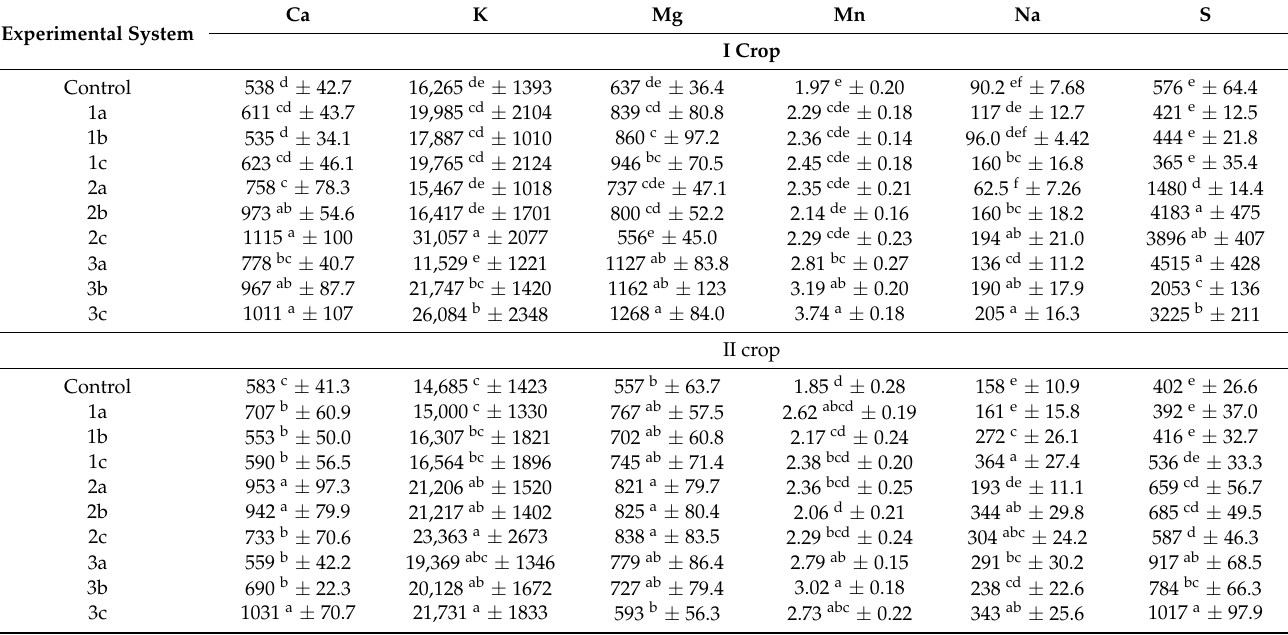
Table 2. Content (mg kg − 1 DW) of selected elements in Pleurotus ostreatus fruit bodies after the I and II